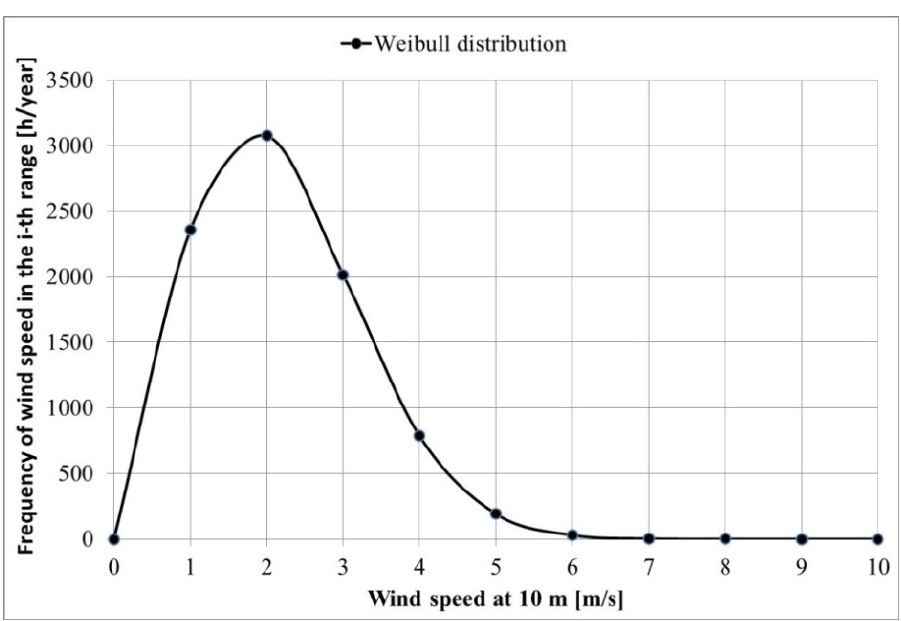
Figure 5. The Weibull distribution for the anemometer at 10 m above ground level for location Iia—city center.